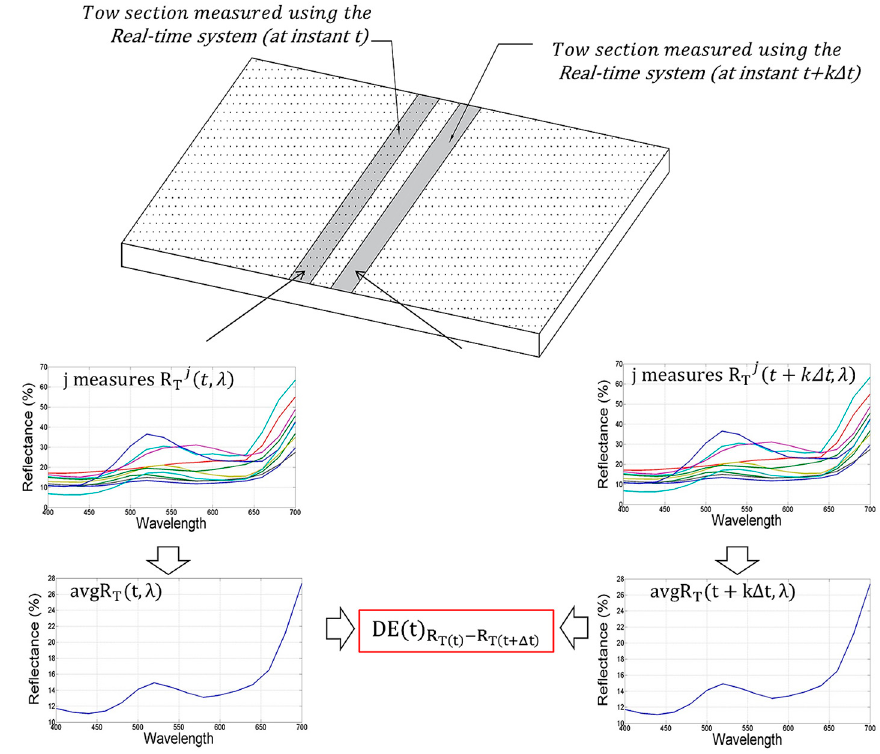
Figure 8. Measurement of the CMC (2:1) color distance between two measurements of the same tow assessed in different instants ( t and t + kΔt ).